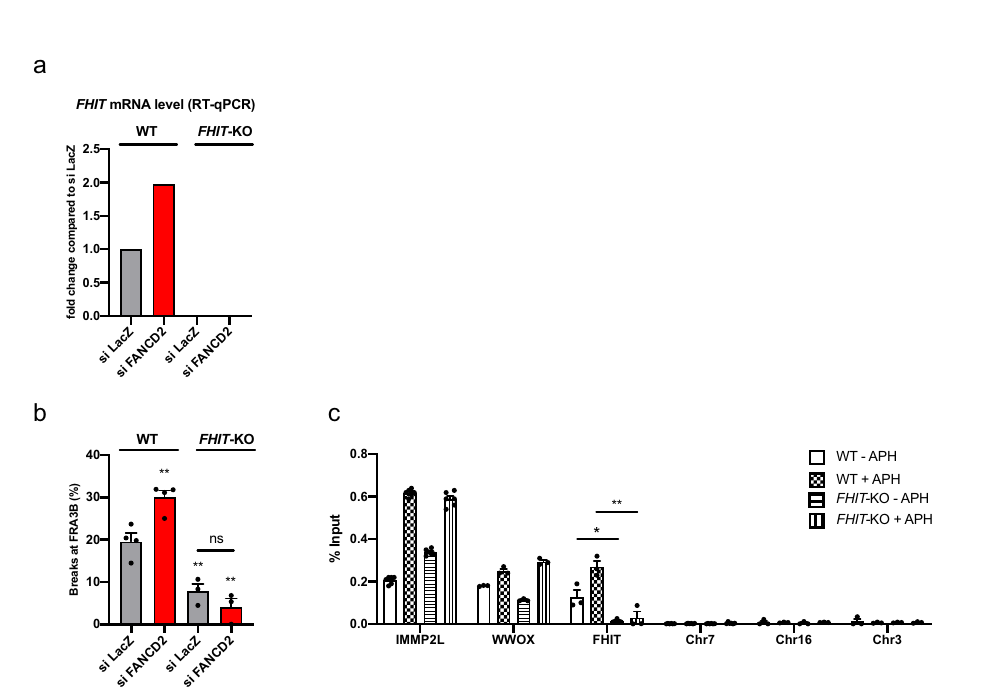
Fig. 2 FANCD2 binds to CFS genes and prevents their instability in a transcription-dependent manner. a FHIT mRNA level detected by RT-qPCR in WT and FHIT -KO cells after control or FANCD2 siRNA transfection. b FRA3B instability in WT and FHIT -KO cells transfected with control or FANCD2 siRNA and treated with 0.3 µ M APH. n = 4 (WT), n = 3 ( FHIT -KO) independent experiments. ** p = 0.0064 (WT_siFANCD2), ** p = 0.0074 ( FHIT -KO_siLacZ), ** p = 0.0028 ( FHIT -KO_siFANCD2). c FANCD2 ChIP followed by qPCR in wild-type (WT) and FHIT -KO cells treated or not with 0.3 µ M APH. The results are expressed as the percentage of input. n = 5 (IMMP2L), n = 3 (WWOX, FHIT). * p = 0.026, ** p = 0.0035. Error bars are standard error of the mean